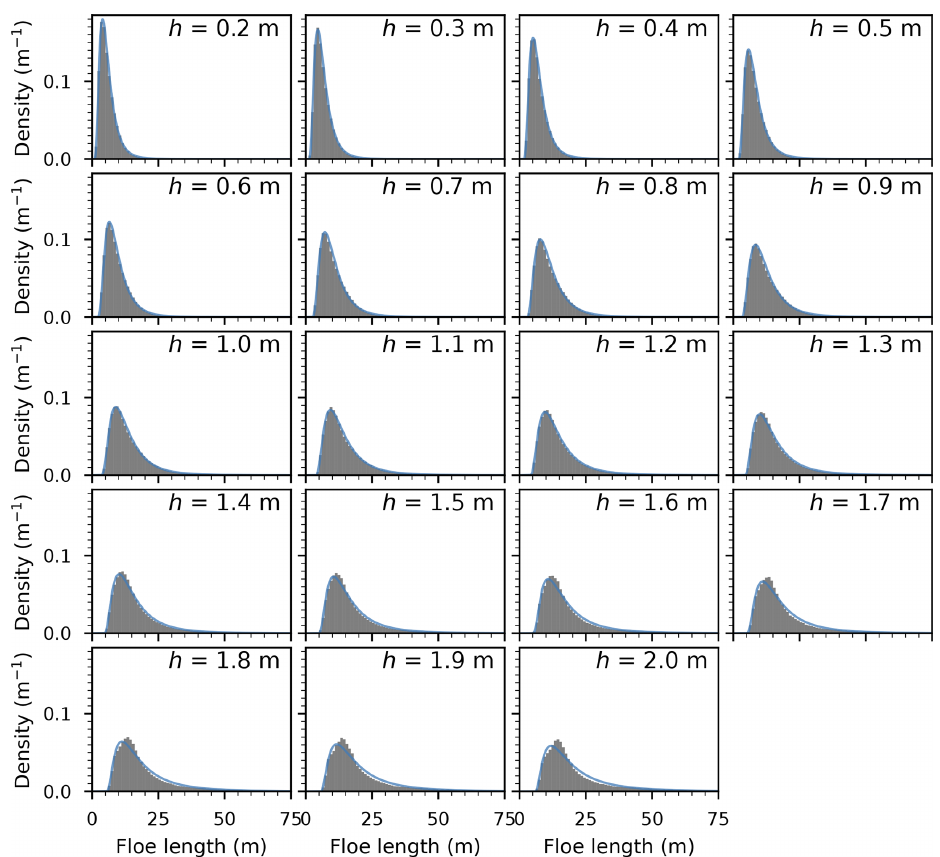
Figure C2. Histograms and average lognormal fits, as described in Sect. 5.2, for varying ice thickness.